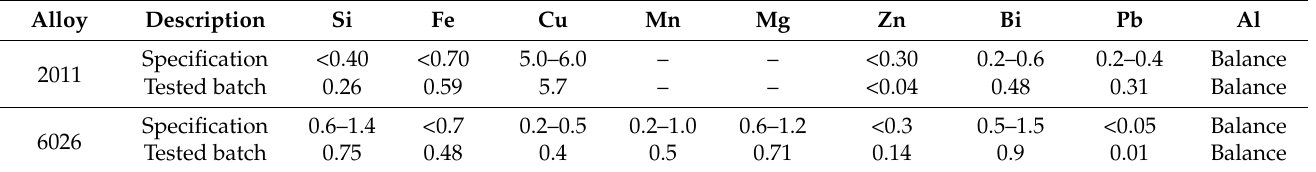
Table 4. Purchase specification and actual analysis for the chemical composition of the aluminum alloys employed for this study (wt%).